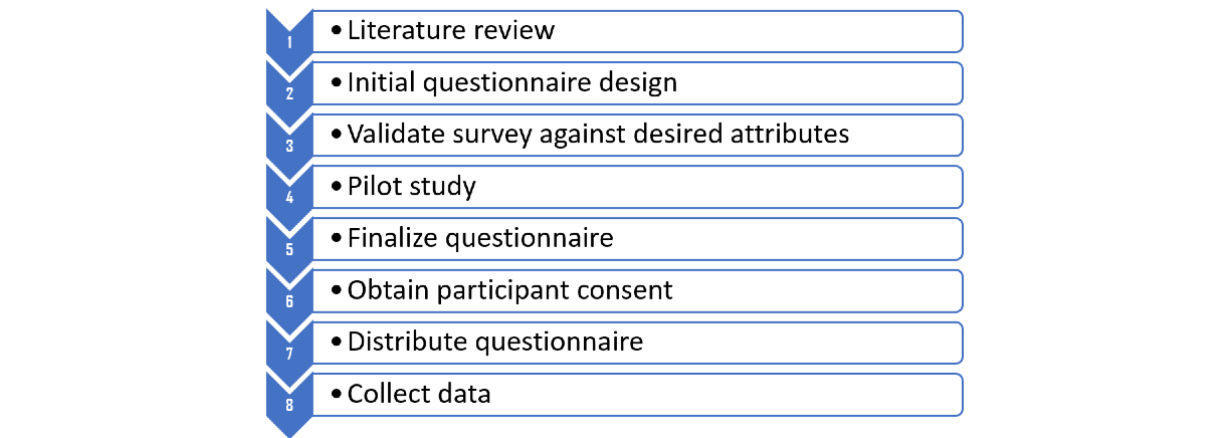
Figure 1. Survey